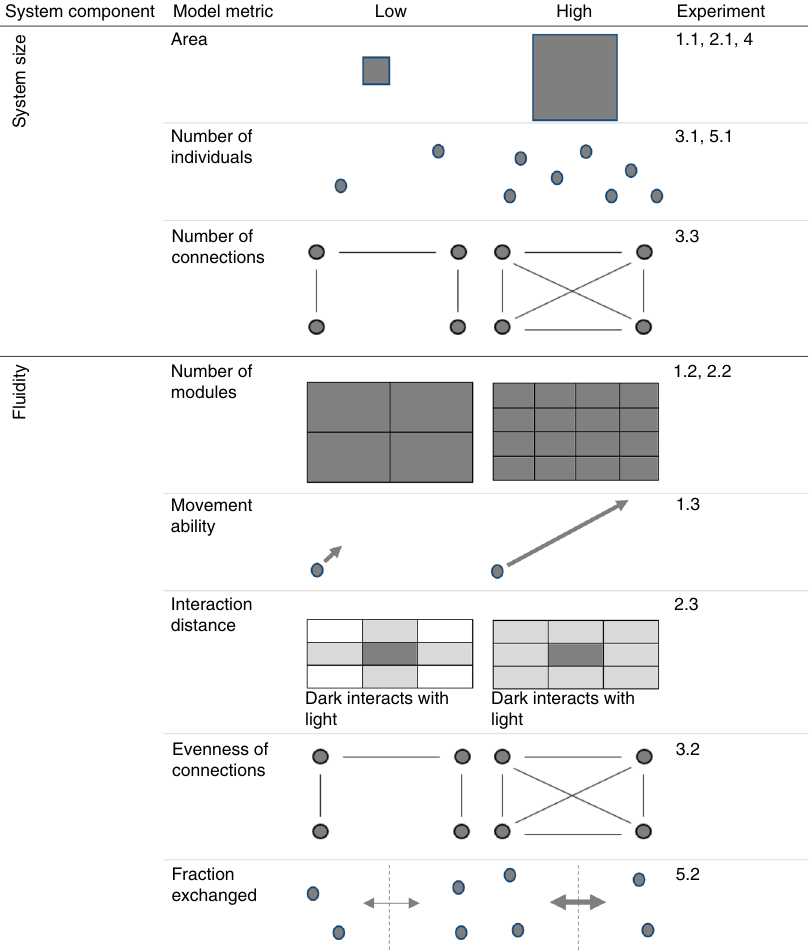
Fig. 1 Graphical representation of the modelling framework. Each row shows two graphics to illustrate the extreme variants (low, high) for a speci fi c metric associated with either system size (upper) or fl uidity (lower) in the 12 modelling